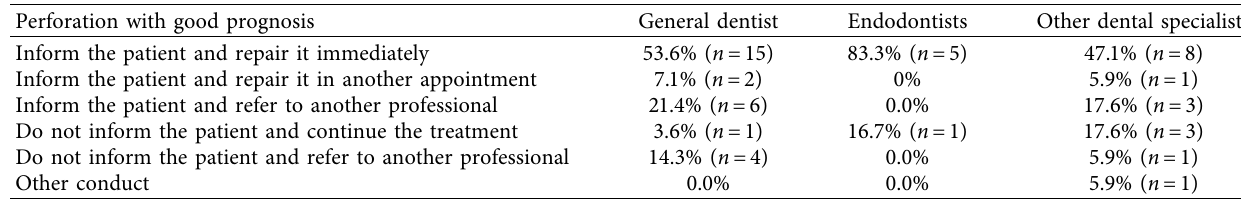
Table 6: Frequency of respondents when related to their conduct in case of perforation with good prognosis ( p ≥ 0.597). Perforation with good prognosis